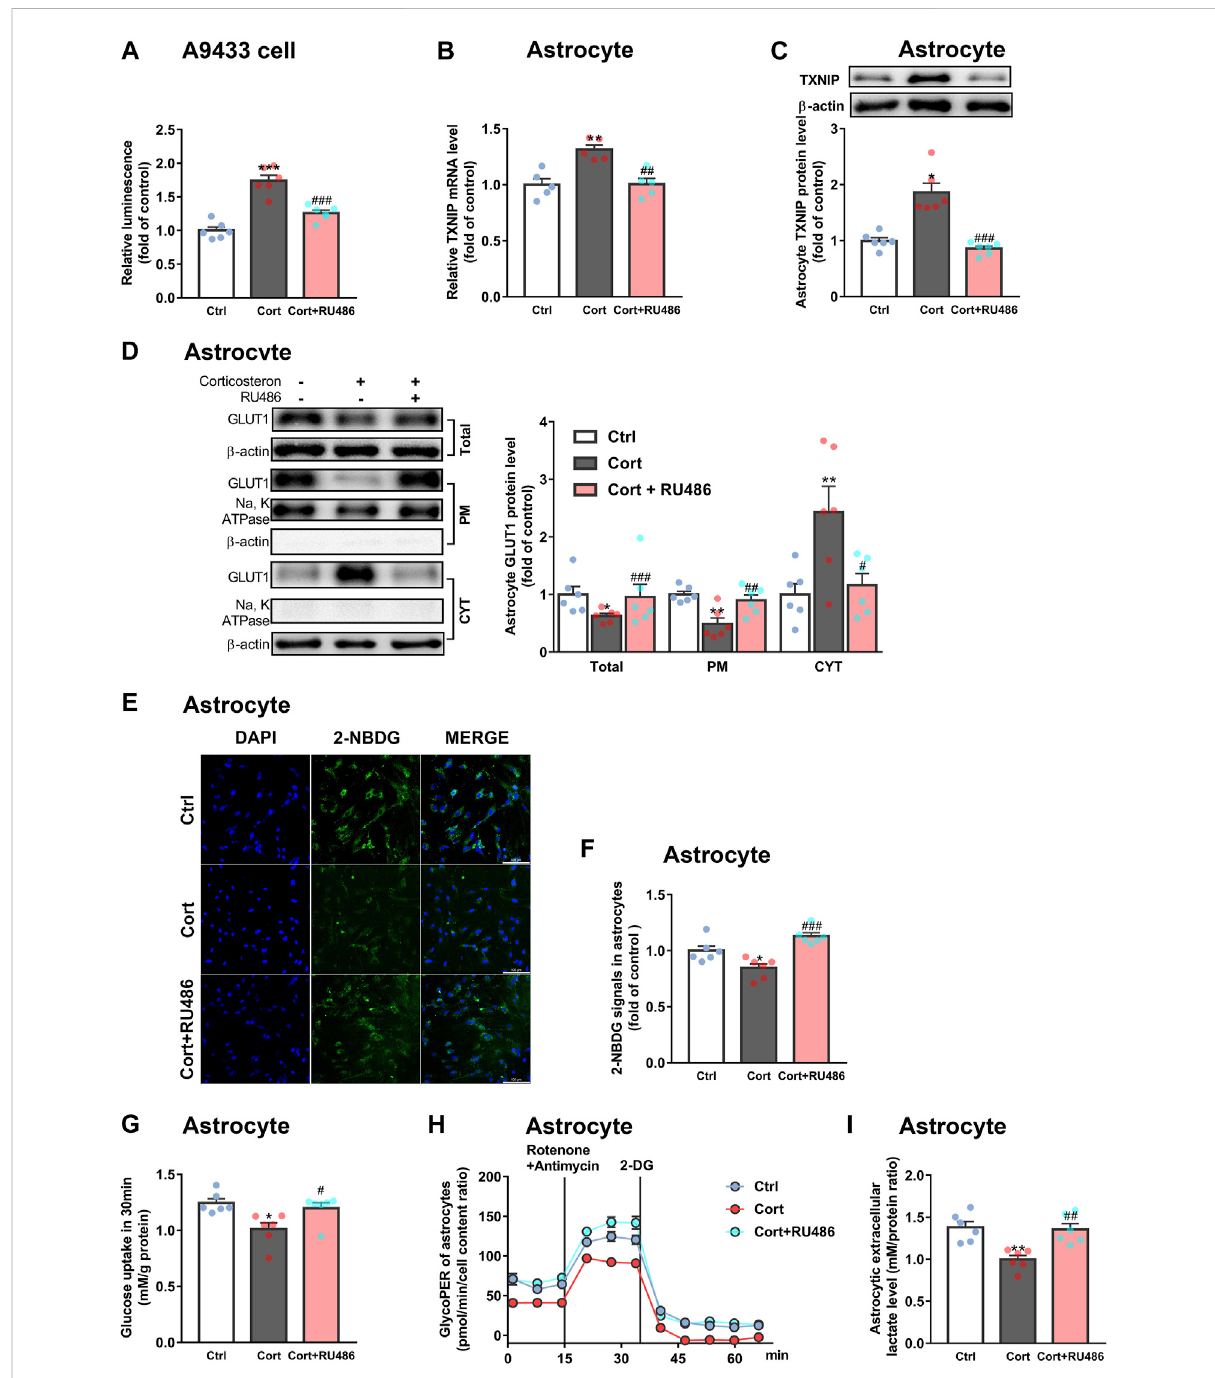
FIGURE 7 RU486 suppresses TXNIP transcription and improves astrocytic glucose uptake and glycolysis. (A) RU486 (1 μ M) inhibited luciferase activity of A9433 cells obviously, n = 6 cell cultures/group; P CortxCort + RU486 < 0.0001. (B,C) RU486 (1 μ M) reduced TXNIP mRNA [ (B) , n = 5 cell cultures/ group; P CortxCort+RU486=0.0017)]andprotein[ (C) , n =6cellcultures/group; P CortxCort+RU486=0.0007)]levelsofprimaryastrocytes. (D – I) RU486 (1 μ M) increased GLUT1 PM translocation [ (D) , n = 6 cell cultures/group; Total: P CortxCort + RU486 = 0.0007; PM: P CortxCort + RU486 = 0.0094; CYT: P CortxCort + RU486 = 0.0188)], 2-NBDG uptake [ (E) , scale bar = 100 μ m; (F) , n = 6 cell cultures/group; P CortxCort + RU486=0.0001)],glucoseuptake[ (G) , n =6cellcultures/group; P CortxCort+RU486=0.0257)],glycolyticrate[ (H) , n =6cellcultures/group)]and lactate release [ (I) , n = 6 cell cultures/group; P CortxCort + RU486 = 0.0095)] of in vitro cultured primary astrocytes. All data were expressed as mean±SEM,* p < 0.05,** p < 0.01,*** p < 0.001vs.Ctrl(control)group, # p < 0.05, ## p < 0.01, ### p < 0.001vs.Cort(corticosterone)